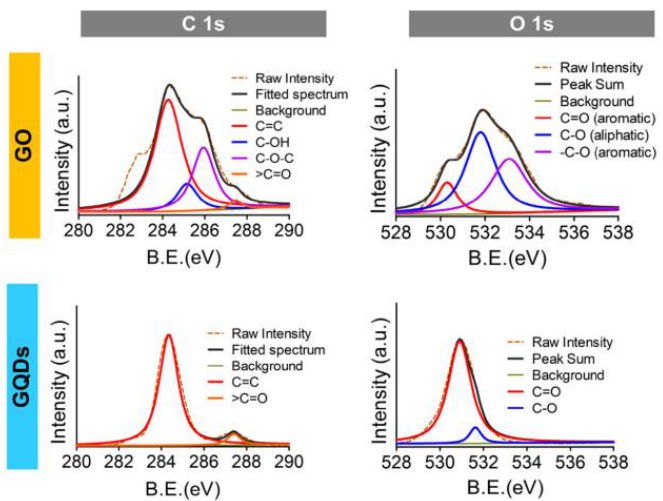
Figure 11. XPS analysis of GO and GOQDs. Reprinted with permission from Ref. [64]. 2019, Elsevier.